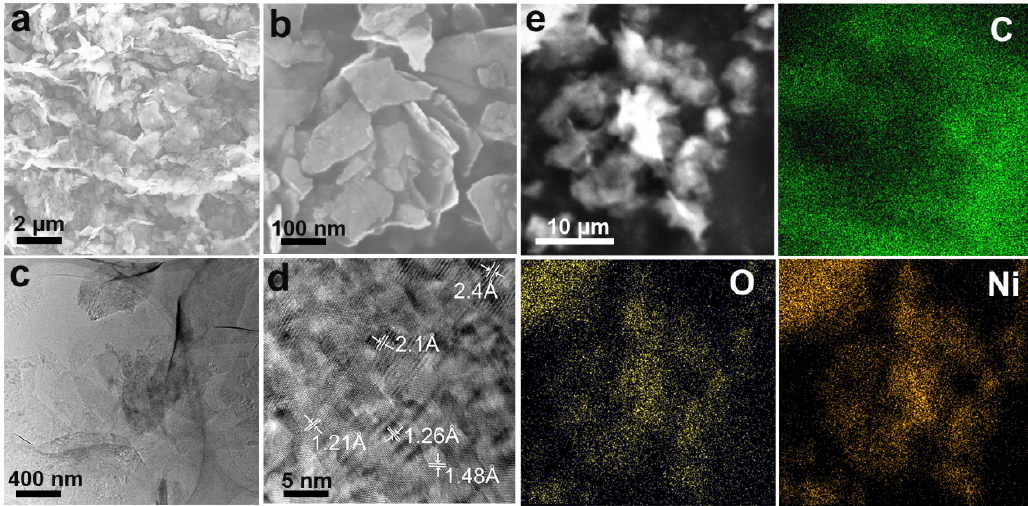
Figure 2. ( a , b ) SEM of the NiO-rGO composite. ( c , d ) TEM of the NiO-rGO composite. ( e ) EDX mapping (C, O, Ni) of the NiO-rGO composite.